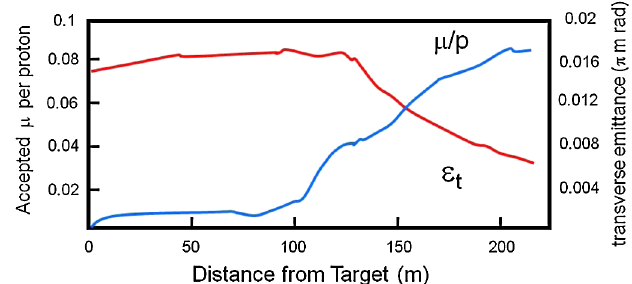
FIG. 4. (Color) Performance of the bunching and cooling chan- nel as a function of distance along the channel, as simulated using the ICOOL code [24,25]. The red line (right-hand scale) shows the evolution of the rms transverse emittance. The blue line (left-hand scale) shows the evolution of the number of muons within a reference acceptance (muons within 201.25 MHz rf bunches with transverse amplitudes less than 0.03 m and longitudinal amplitudes less than 0.2 m). The cooling section starts at s ¼ 124 m , where the rms transverse emittance is (cid:2) 0 : 017 m and (cid:2) 0 : 040 (cid:2)= p are in the reference acceptance, and continues to s ¼ 217 m . Acceptance is maximal at 0 : 085 (cid:2) þ per initial proton at s ¼ 201 m (75 m of cooling), where the rms transverse emittance is 0 : 007 (cid:1) m rad . At s ¼ 173 m (59 m of cooling) the (cid:2)=p is (cid:2) 0 : 072 , where the transverse emittance is (cid:2) 0 : 0093 m . If the longitudinal acceptance is reduced to 0.15 m, the production is (cid:2) 0 : 076 (cid:2)=p at s ¼ 201 m and (cid:2) 0 : 067 (cid:2)=p at s ¼ 173 m .